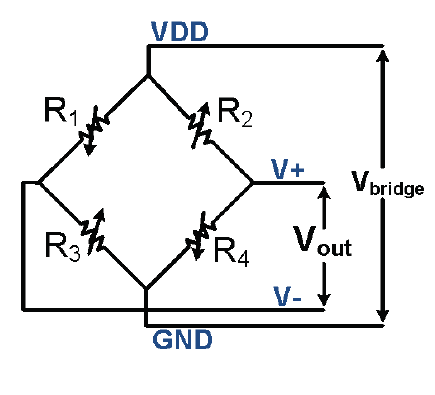
Figure 4. Wheatstone